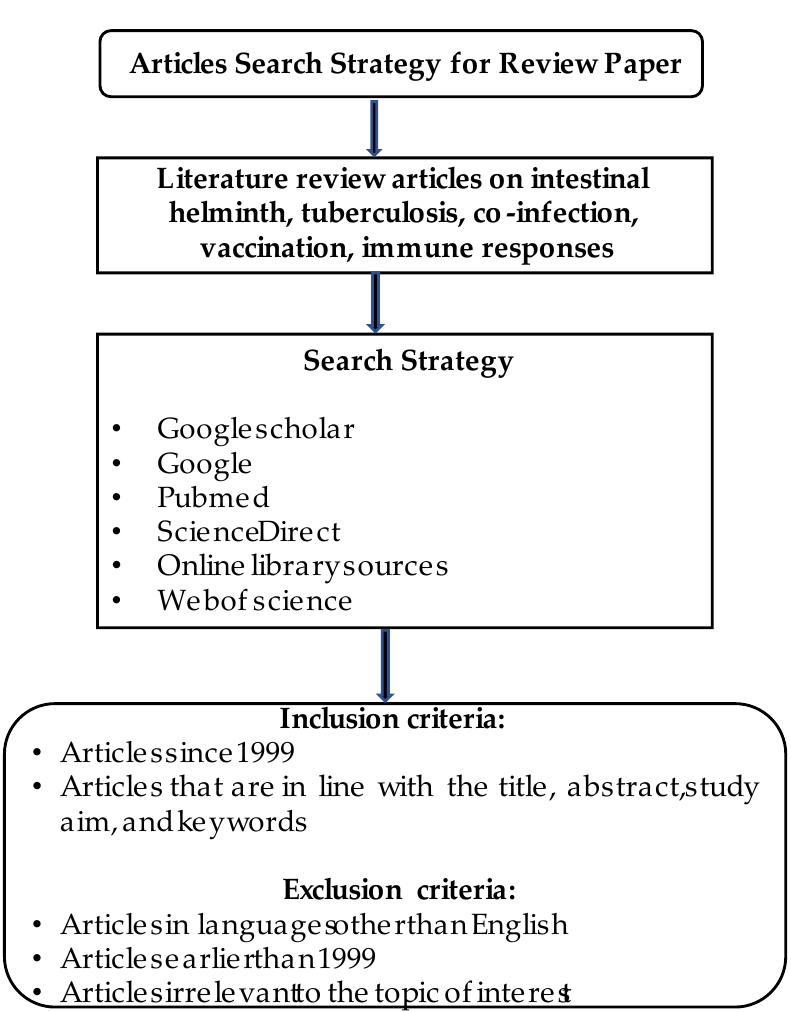
Figure 1. PRISMA flow diagram of the search strategy and the research design process.